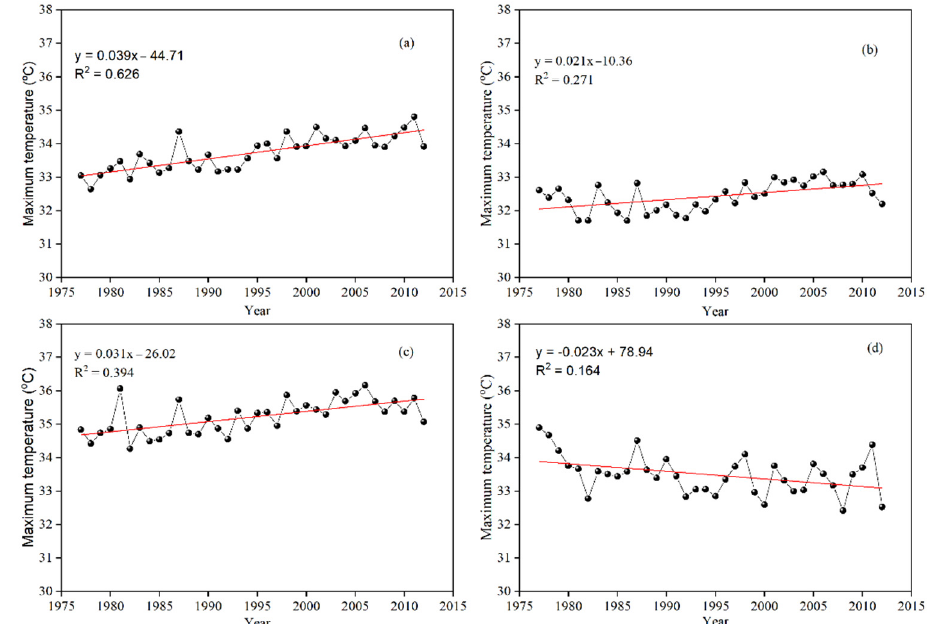
Figure 5. Annual maximum monthly temperature at ( a ) Kara, ( b ) Niamtougou, ( c ) Mango and ( d ) Dapaong.